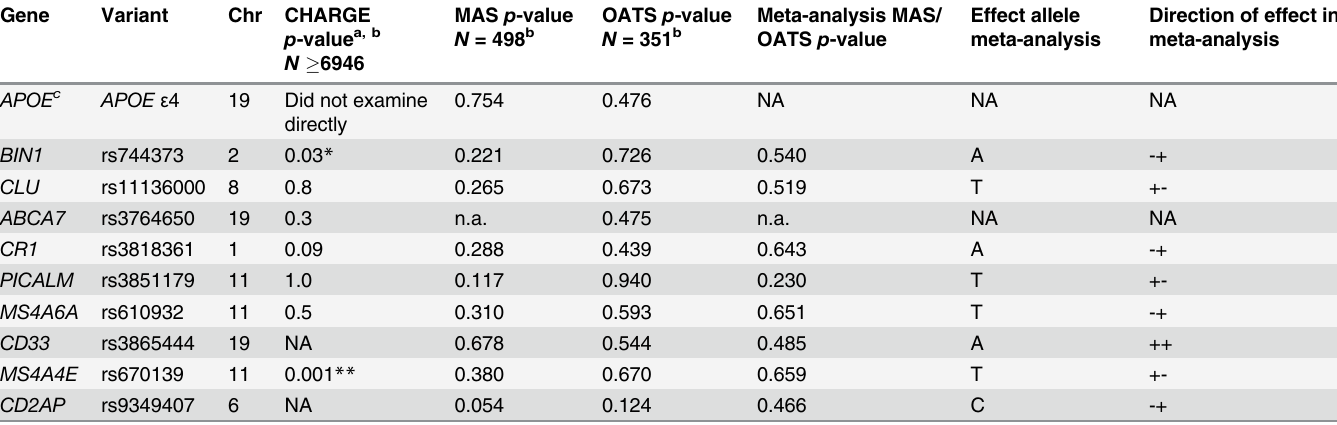
Table 3. HV Association results examining the top 10 ranked genetic polymorphisms for late-onset Alzheimer ’ s Disease in the CHARGE discovery meta-analysis, Sydney MAS, OATS and meta-analyses of MAS/OATS. Gene